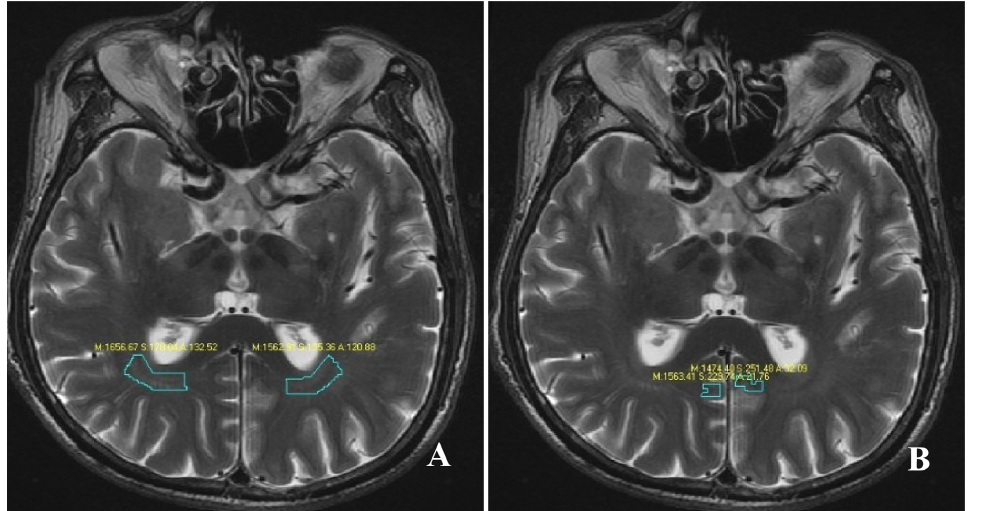
Figure 2. Regions of interest in the measurement of T2 intensity. Figure 2A displayed the ROIs of the GCTs, while Figure 2B displayed the ROIs of the striate